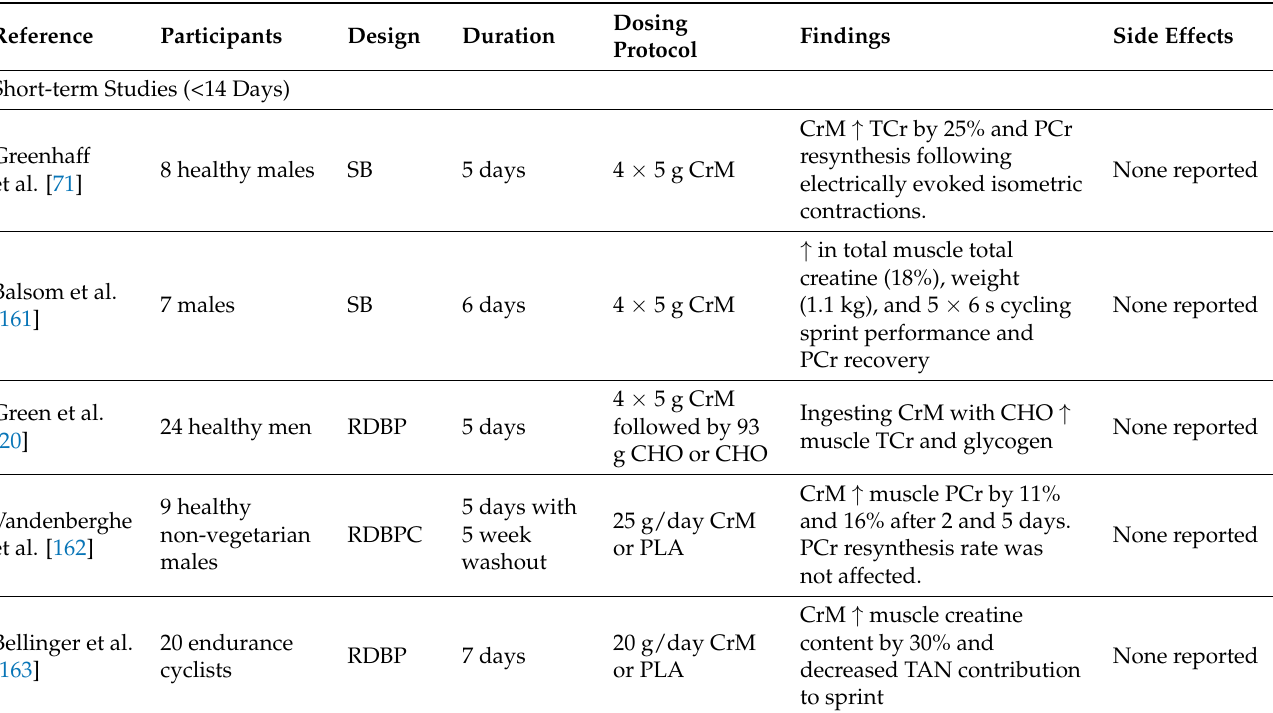
Table 2. Example of studies showing bioavailability, efficacy, and safety of CrM